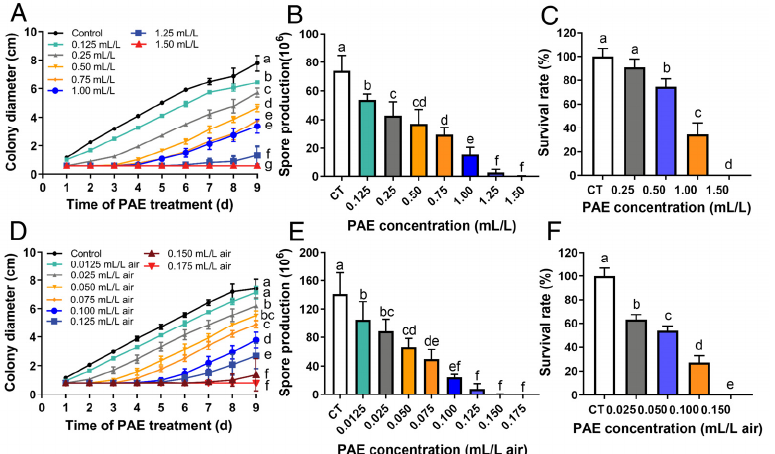
Figure 2. Effects of PAE on mycelial growth, spore production and viability of F. solani . Colony diameter ( A ) and spore production ( B ) analyzed by contact method after mycelial plugs were incubated with different concentrations of PAE for 9 d. Colony diameter ( D ) and spore production ( E ) evaluated via vapor phase method after mycelial plugs were incubated with indicated concentrations of PAE for 9 d. Spore survival rate assessed by contact method ( C ) and vapor phase method ( F ) after spores were incubated with different concentrations of PAE for 5 d. All data are presented as mean ± standard deviations ( n = 3). Different letters indicate statistical significant differences ( p < 0.05) calculated by one-way ANOVA.